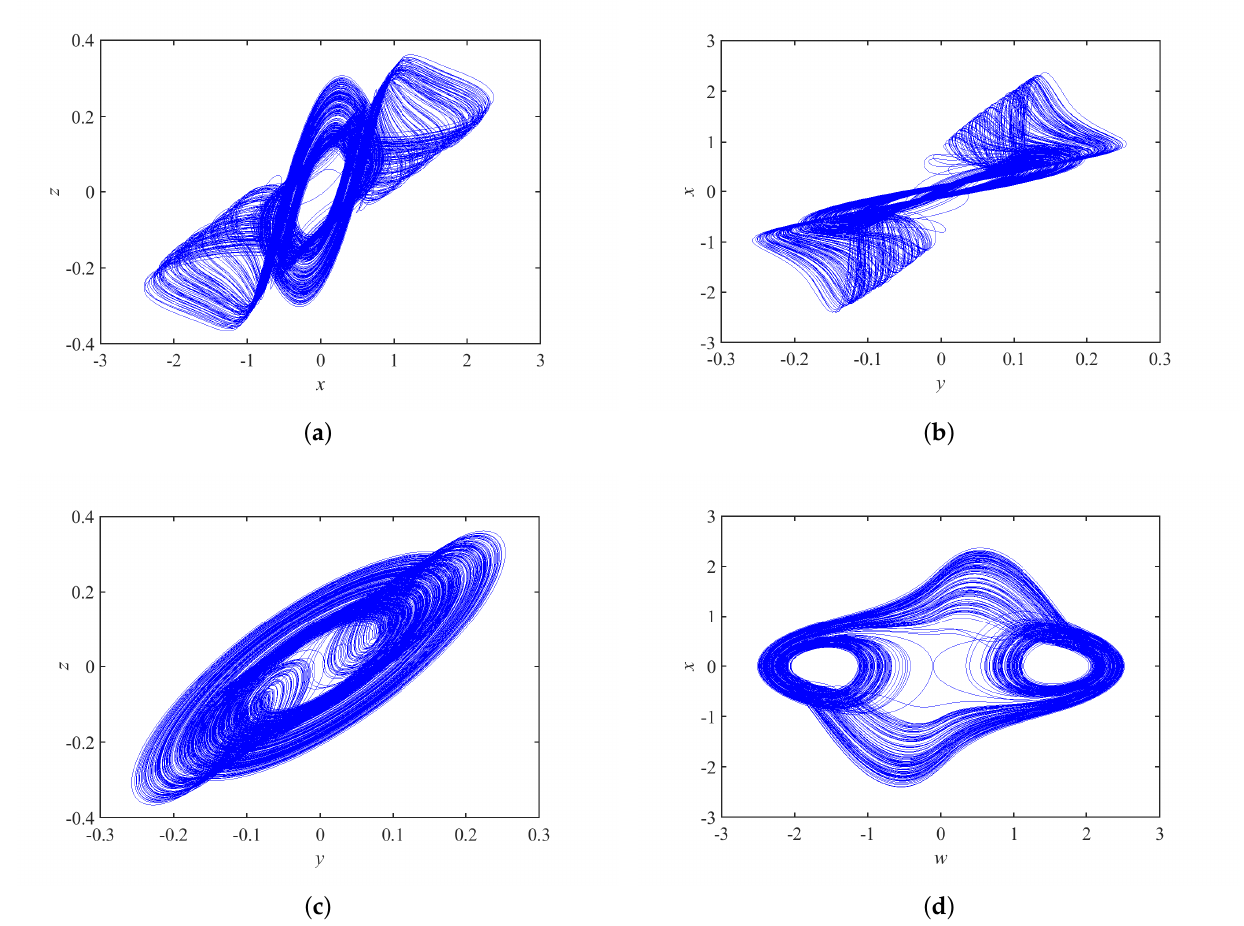
Figure 3. Phase portrait of the proposed chaotic system on ( a ) x–z plane, ( b ) y–x plane, ( c ) y–z plane, and ( d ) w–x